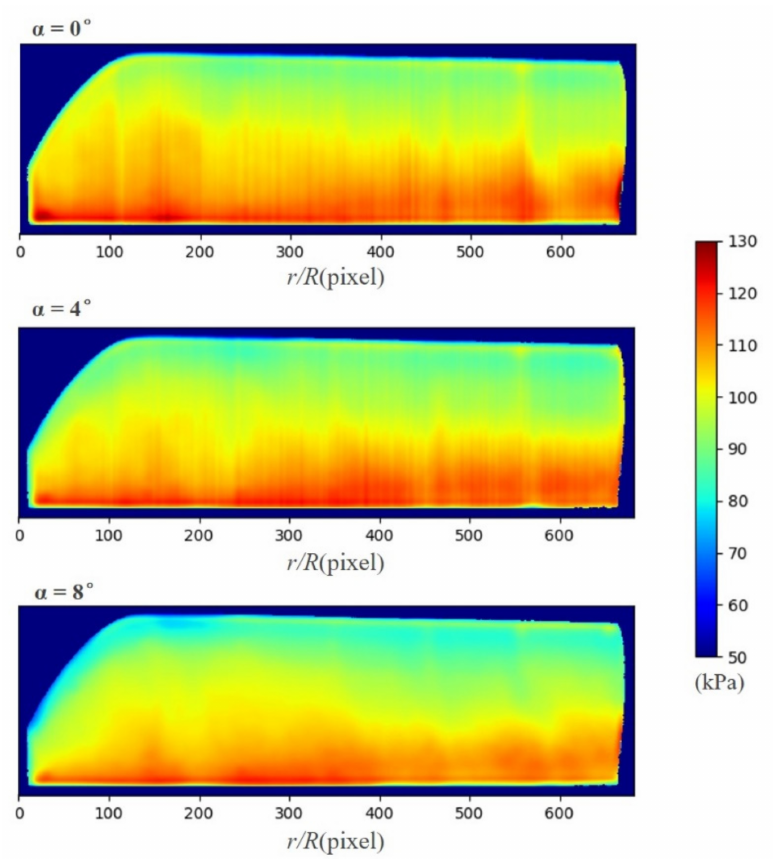
Figure 12. Pressure field distribution under different pitch angles measured by